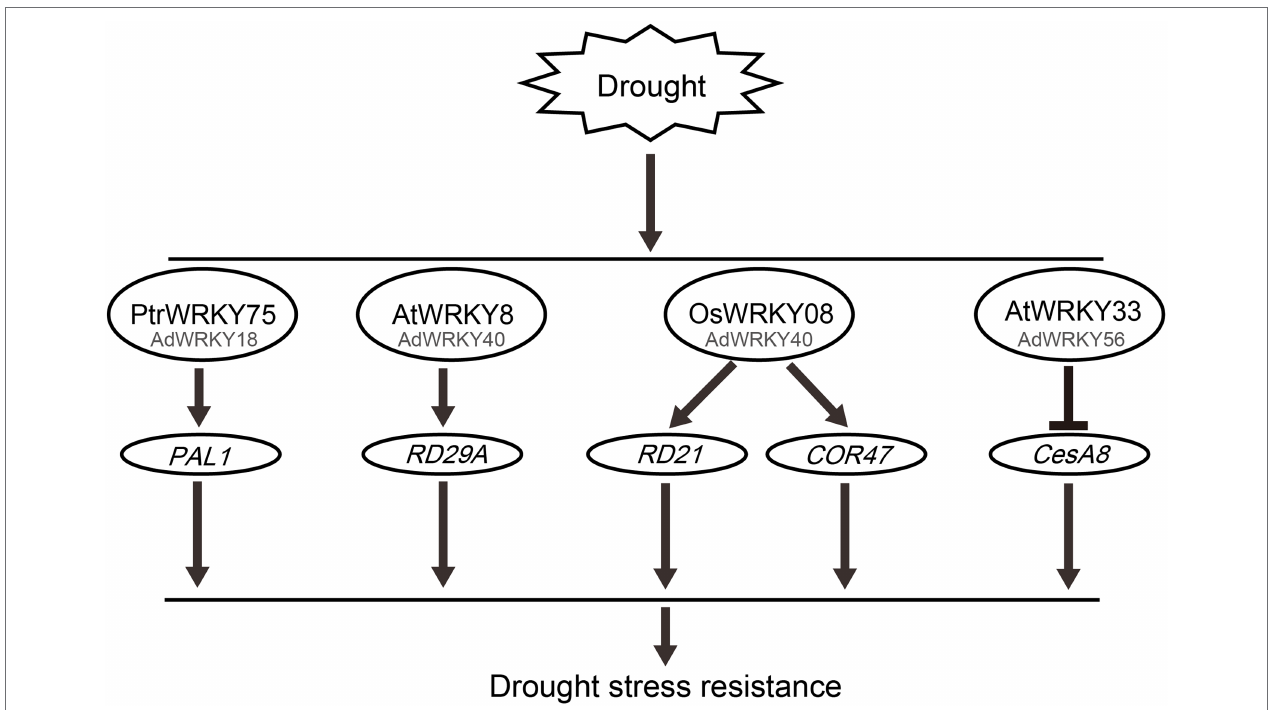
FIGURE 2 | Potential roles of AdWRKYs regulate downstream genes under drought stress. The datasets are obtained from previous studies, including PtrWRKY75 (Zhang et al., 2020b), AtWRKY8 (Hu et al., 2013), OSWRKY8 (Song et al., 2010), and AtWRKY33 (Wang et al., 2013). The WRKY activates PAL1, RD29A, RD21, and COR47 genes expression, and represses CesA8 gene